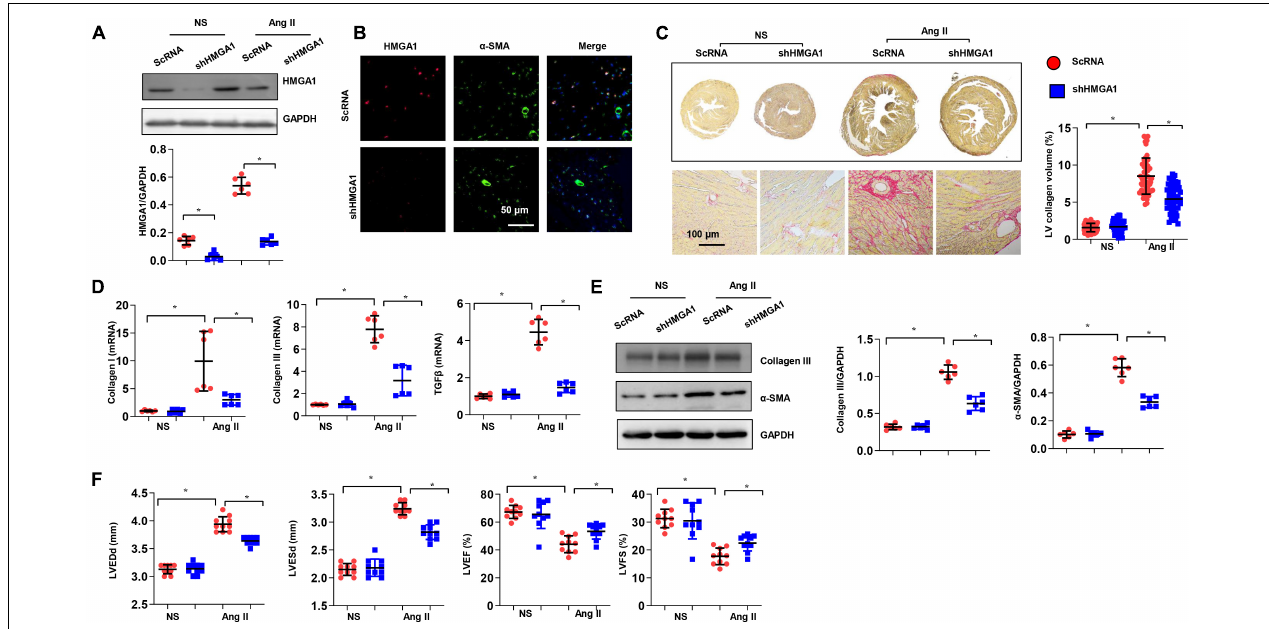
FIGURE 7 | High-mobility group A1 (HMGA1) knockdown alleviated cardiac fibrosis and dysfunction induced by angiotensin II (Ang II) in mice. (A) The protein level of HMGA1 in mouse hearts 3 weeks after AAV9-shHMGA1 injection ( n = 6). (B) Immunofluorescence staining of HMGA1 and α -SMA in heart tissue post-AAV9-shHMGA1 injection and Ang II infusion ( n = 5). (C) PSR staining image and quantitative result of left ventricular collagen volume in mouse hearts 28 days after Ang II infusion ( n = 5). (D) Transcription levels of collagen I, collagen III, and TGF β 1 ( n = 6). (E) Protein levels of collagen III and α -SMA in heart tissue ( n = 6). (F) Echocardiographic results in each group ( n = 10). * p <